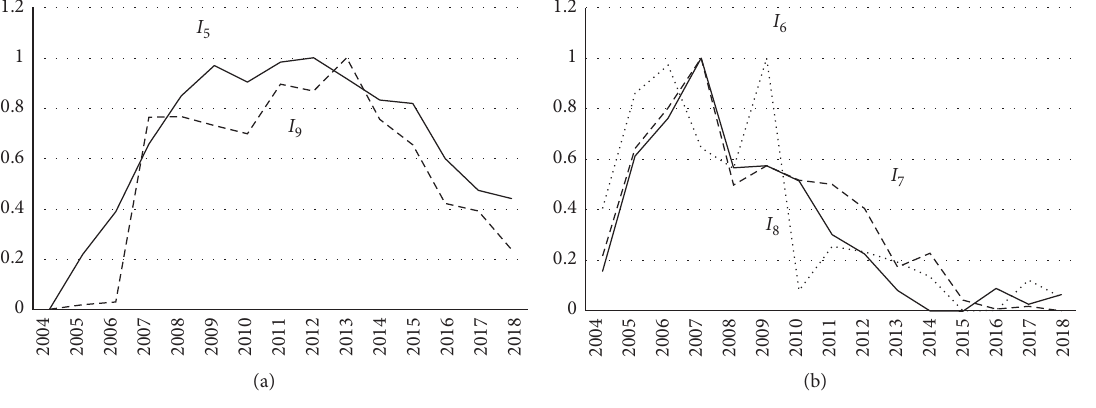
Figure 5: Dynamics of the factors of the level of illegal drug use and drug addiction (normalized values).